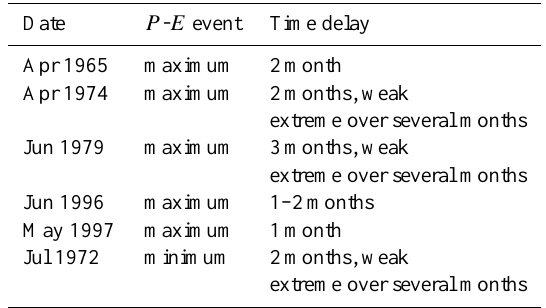
Table 2. Time delays of Volga River P - E extremes after P - E ex- tremes over the Volga Basin. For years earlier than 1989 data form ERA40 are